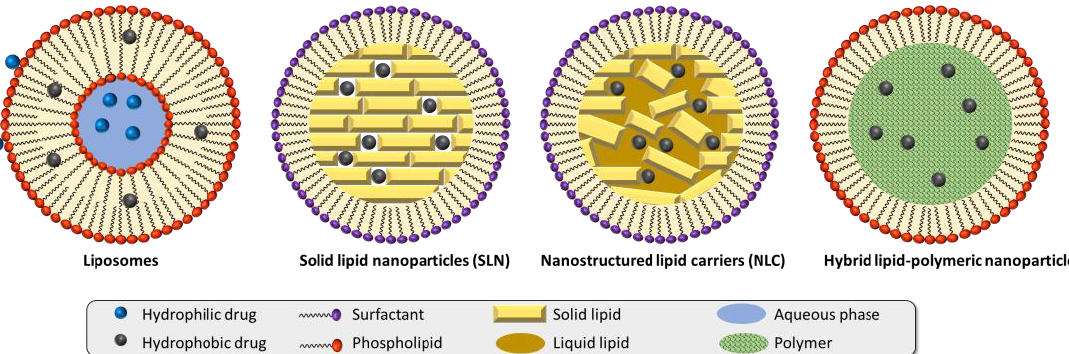
Figure 1. Different types of lipid nanoparticles. Adapted with permission from [24]. Copyright 2022, John Wiley & Sons.